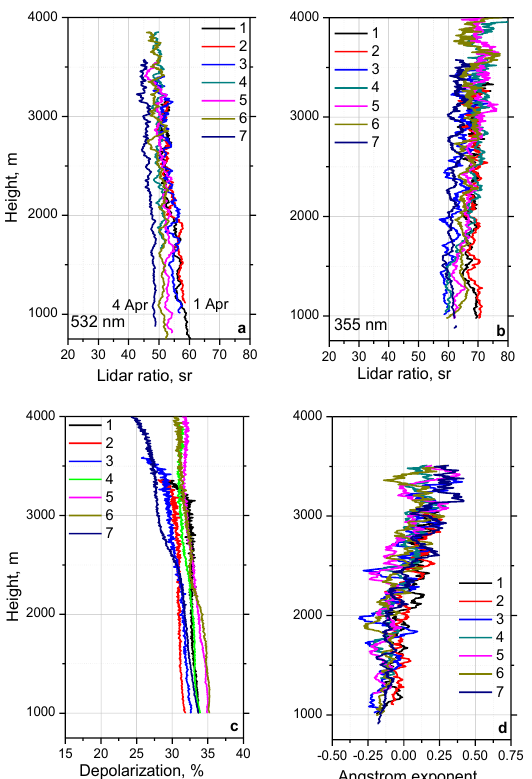
Figure 3. Vertical profiles of (a) extinction and backscattering coefficients at 355 and 532 nm, (b) lidar ratios, Angstrom exponent and relative humidity, (c) particle depolarization and decomposition of β 532 for dust and smoke